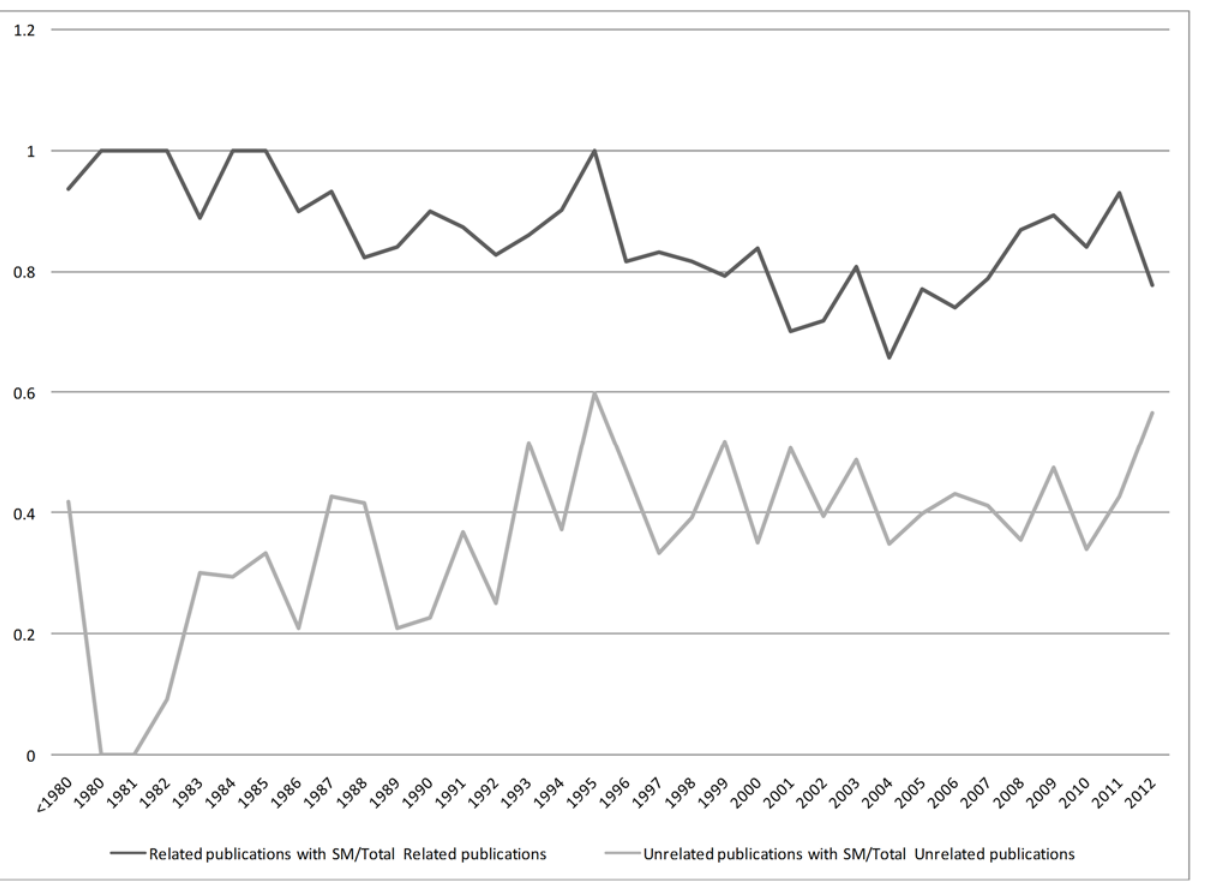
Fig 4. Proportion of Related and Unrelated Publications Which Used SM Terms in Their TIAB.